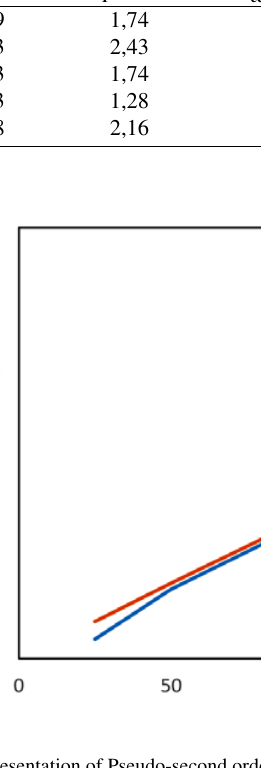
Figure 4. Graphical representation of Pseudo-second order kinetic